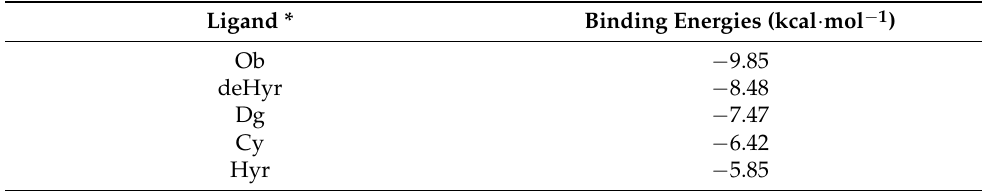
Figure 4. Near view of cardiac glycosides (stick representations) docked into Na + /K + -ATPase (purple, image representations; orange, individual residues, stick representations) with the lowest binding energy mode. The cardiac glycoside binding site in the Na + /K + -ATPase is indicated. ( A ) Ouabain, ( B ) cymarin, ( C ) digitoxin, ( D ) hyrcanoside (in blue) and deglucohyrcanoside (in green). The images were taken using PyMOL 2.3.3 (Schrödinger, LLC, New York, NY, USA). Table 1. Binding energies of cardiac glycosides docked into Na + /K +